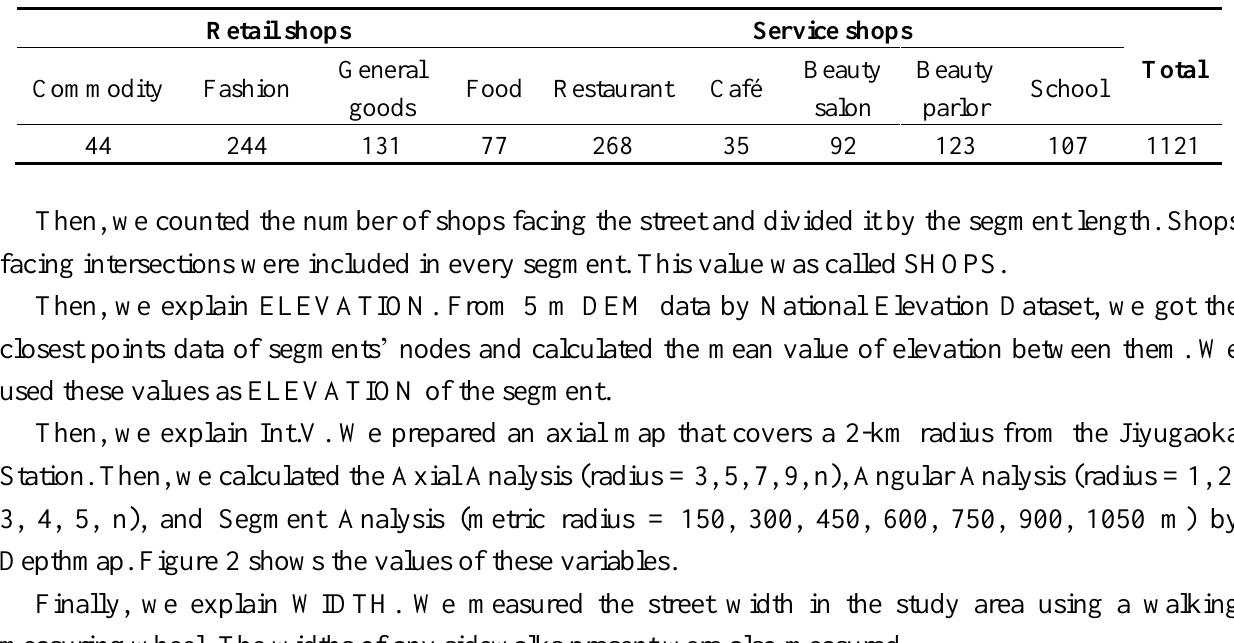
Table 2. Number of each of the main shop-types.